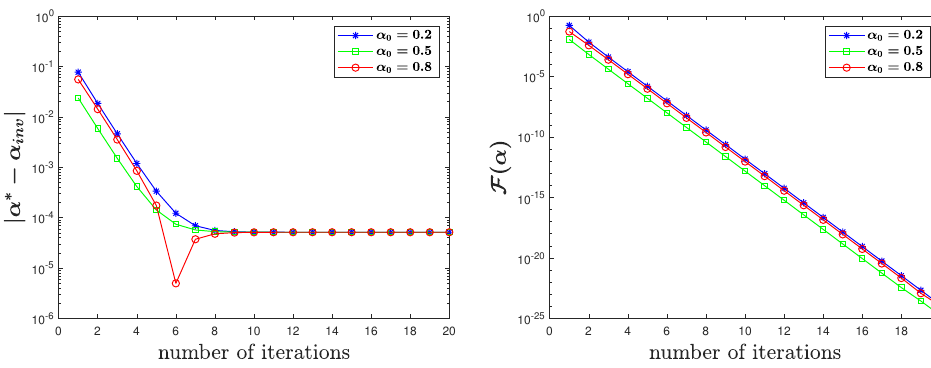
Figure 3. α ∗ = 0.6 for uncontaminated observation data in Test 1.